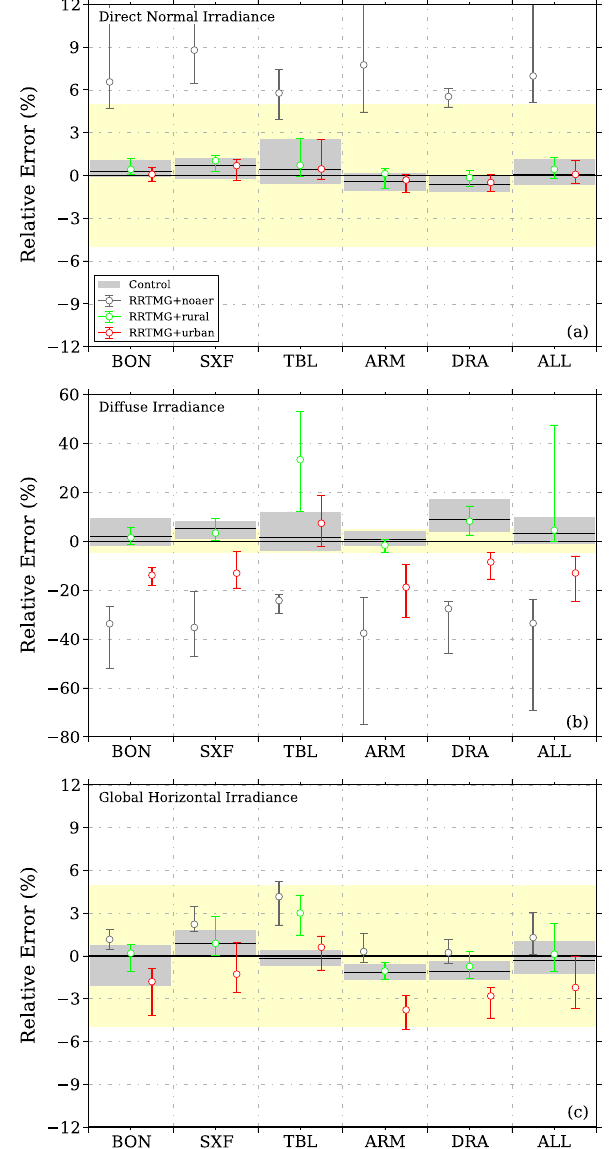
Figure 3. Relative error of both the control experiment and the test cases as compared against the GHI, DNI and DIF ground observa- tions at each site and the composite of all sites (ALL). The statistics are based on 767 samples for GHI and DIF and 892 samples for DNI. The number of samples per site varies between 150 and 200. The yellow-shaded area highlights the ± 5 % error region as a rough reference of the expected observational error. The grey blocks re- fer to the control experiment and encompass the region around the mean relative error (horizontal black line) that contains 66% of the experimental points at each site (33% above the mean error and 33% below). The relative error obtained in the test cases is indi- cated with the vertical bars at each site. They also encompass 66% of the experimental points, the white circle mark being the mean relative